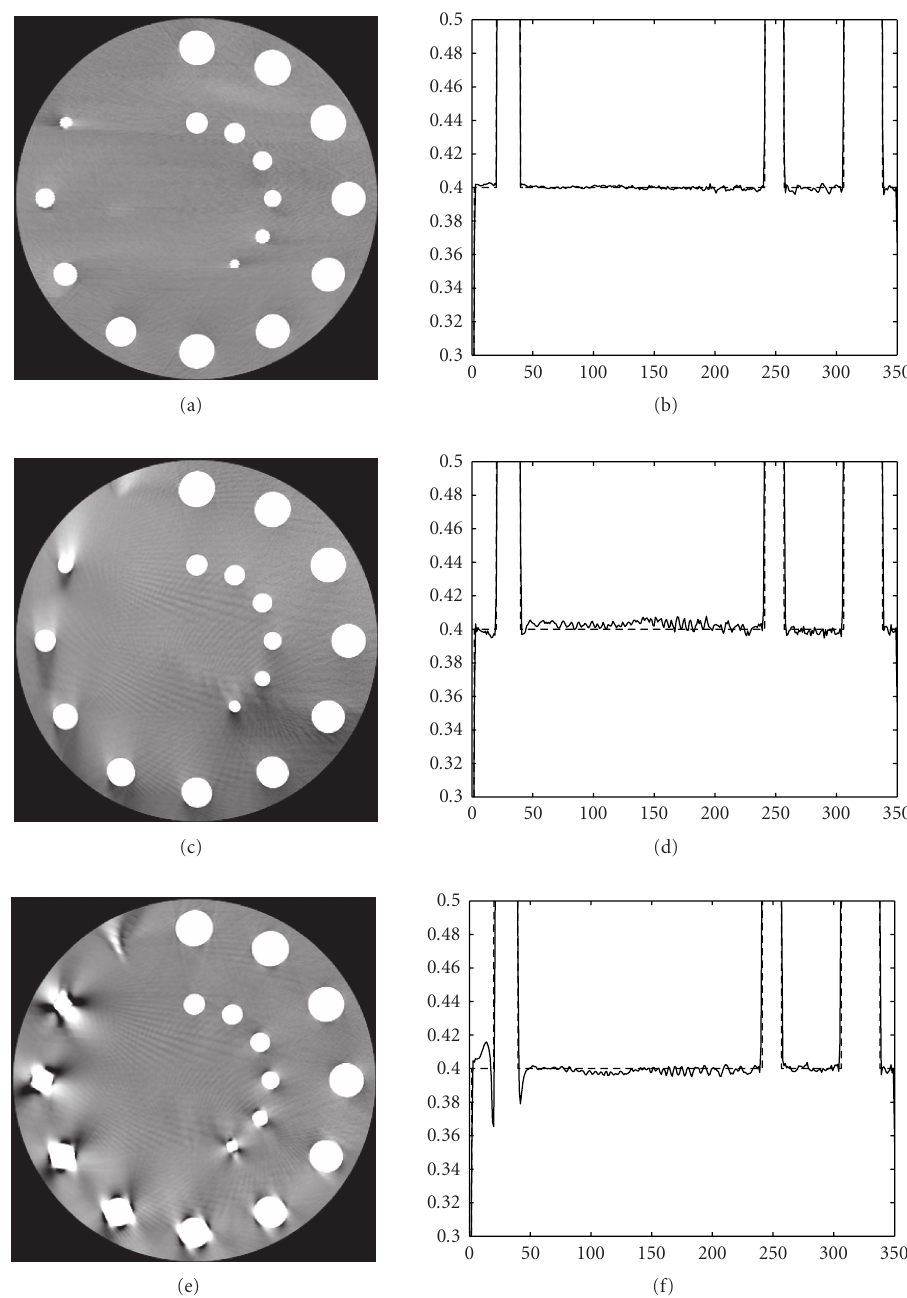
Figure 5: Images for the plane z = 0 mm of clock phantom generated with the proposed algorithm, gantry-tilted FDK, and gantry-tilted ASSR with S = 1mm, p = 1 . 0, M = 96 (0 . 35 − 0 .